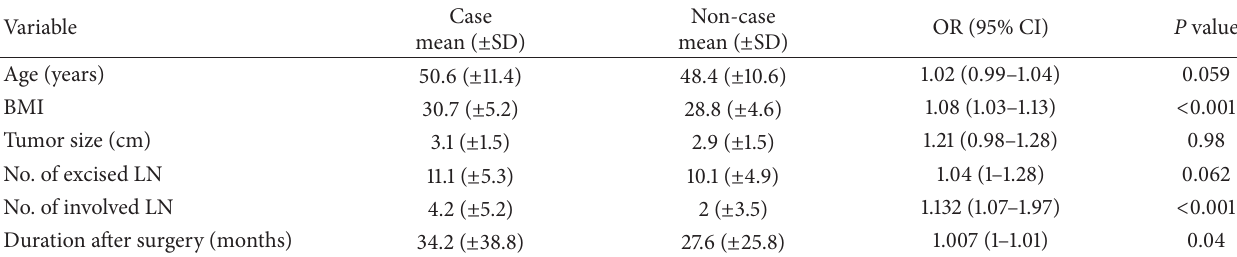
Table 2: Demographic and clinical characteristics of patients (numeric variables).